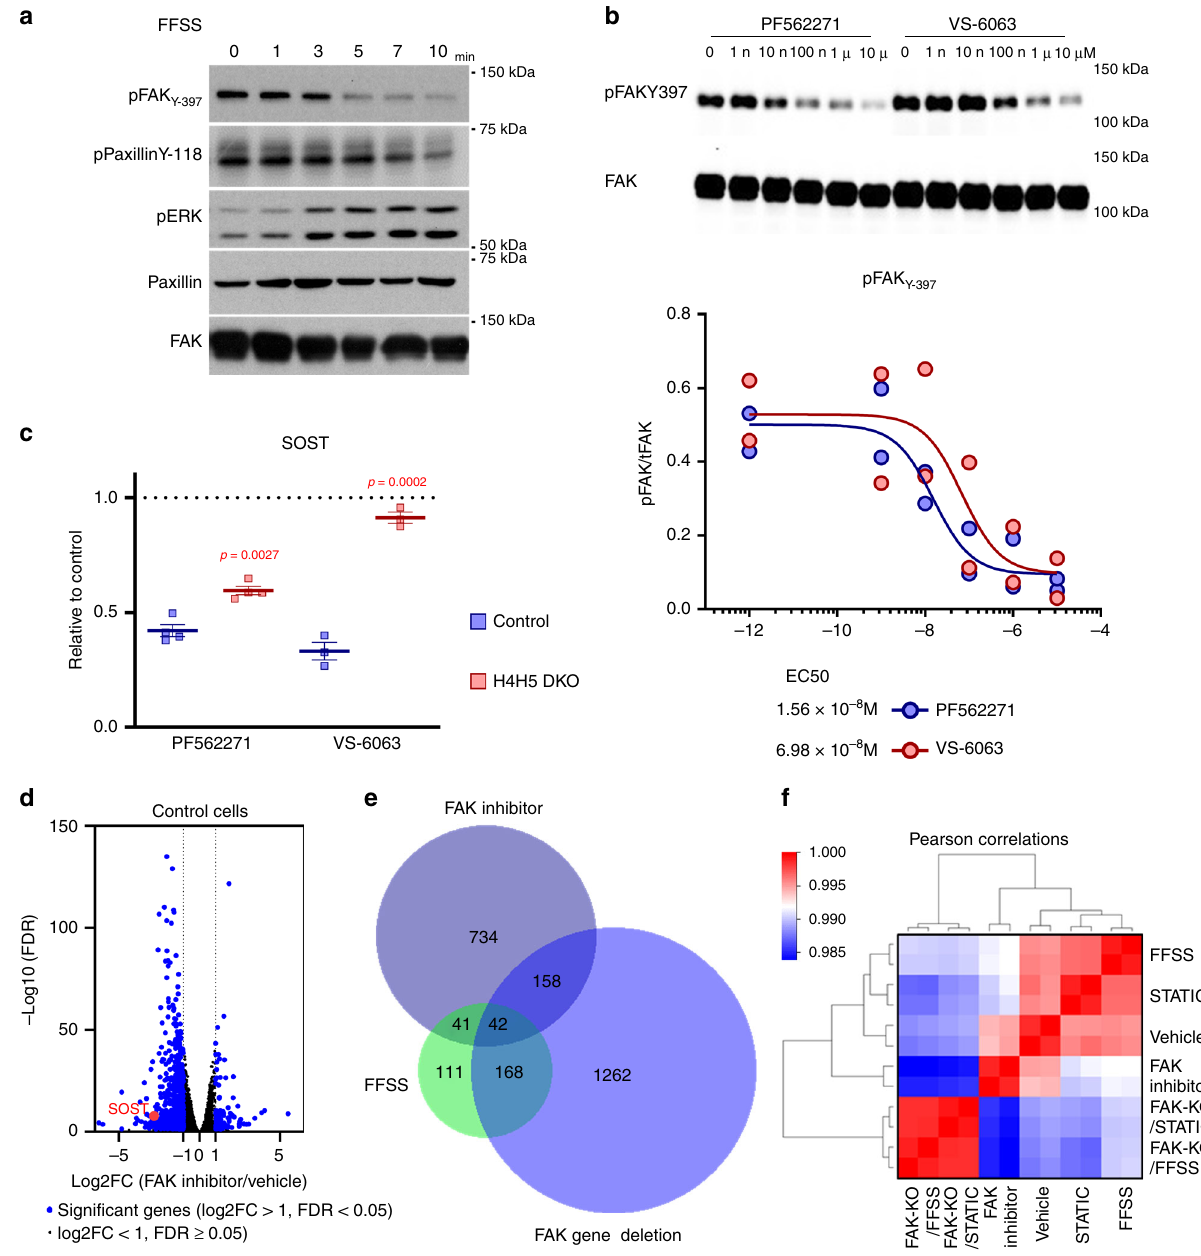
Fig. 4 FFSS reduces FAK activity, and FAK inhibitors mimic effect of FFSS. a Protein expression of phospho-FAK (Y397), p-paxillin (Y118), and paxillin in Ocy454 cells exposed to FFSS for the indicated times. Phospho-FAK (Y397) was signi fi cantly decreased by FFSS within 10 min, and paxillin (the substrate of FAK) phosphorylation was decreased at later time points. b Dose responses of FAK inhibitors (PF562271 and VS-6063) on Ocy454 cells. FAK inhibitors were treated with indicated concentrations for 1 h. FAK inhibitors signi fi cantly reduced phospho-FAK (y-397) activity. Immunoblotting data are quanti fi ed in the bottom graph ( n = 2 biologic protein replicates were performed). Data are shown with each measured value and best fi t curve. c Control and HDAC4/5 compound mutant (H4H5-DKO) cells were treated plus/minus FAK inhibitors for 4 h followed by SOST RT-qPCR. H4H5-DKO cells fail to suppress SOST in response to FAK inhibitor treatment. ( n = 4 RNA replicates for control, and n = 3 RNA replicates for H4H5-DKO were performed) P -values adjusted for multiple comparisons vs control are shown. d A volcano plot of RNA-seq analysis with FAK inhibitor, PF562271. RNA-seq analysis was performed with Ocy454 cells by vehicle and PF562271 treatment for 4 h. Signi fi cant genes were determined as log2FC> |1| and FDR < 0.05. e A Venn diagram of signi fi cantly changed genes among FFSS, FAK inhibitor (PF562271), and FAK gene deletion. FFSS was performed for 3 h with Ocy454 cells infected with a mock sgRNA-expressing lentivirus. Control uninfected Ocy454 cell were treated with FAK inhibitor for 4 h. FAK gene deletion was carried out by CRISPR-Cas9, and single-cell FAK-KO cell line was generated from bulk FAK-KO cell lines with puromycin selection. f A Pearson correlation matrix heatmap of RNA-seq analysis. Ocy454 cells were treated with/without FFSS, with/without FAK inhibitor (PF562271), and with/without FAK gene deletion by CRISPR-Cas9. One-way ANOVA followed by Tukey – Kramer post hoc test were used ( c ). Data are expressed as mean ± SEM. Each experiment was repeated three times ( a , b ). Source data are provided as a Source Data fi